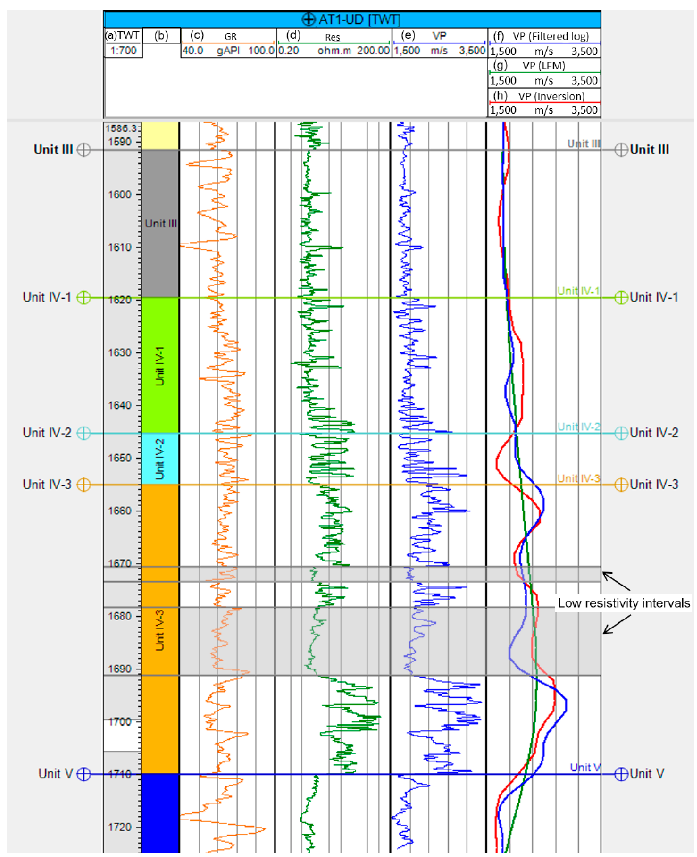
Figure 8. The well log data and seismic inversion results: ( a ) two-way-time scale (TWT); ( b ) geological unit; ( c ) natural gamma ray log (GR); ( d ) resistivity log (Res); ( e ) P-velocity from sonic logs (Vp); ( f ) filtered Vp log applied by a high cut filter of 87.5 Hz; ( g ) Vp, low-frequency model (LFM) used for the seismic inversion; and ( h ) Vp, result of the seismic inversion. The lines ( g ) and ( h ) are extracted at the location of the UD well.